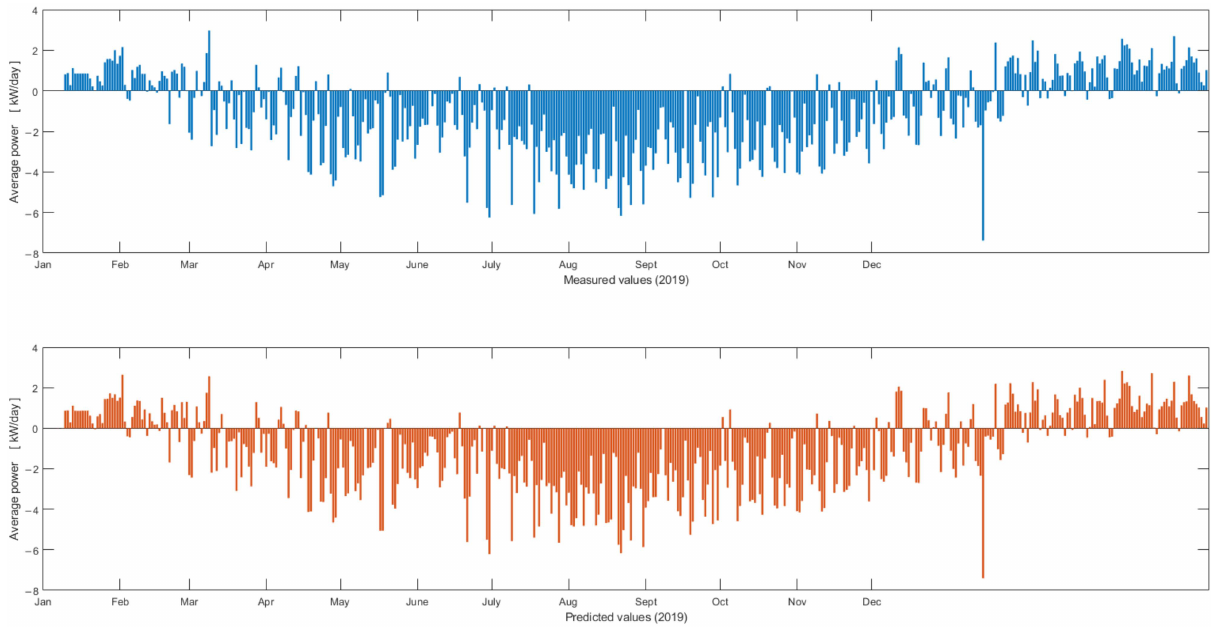
Figure 14. Measured (top—blue) and predicted (bottom—orange) unified electric power production and consumption over the year 2019 (one-day average electric